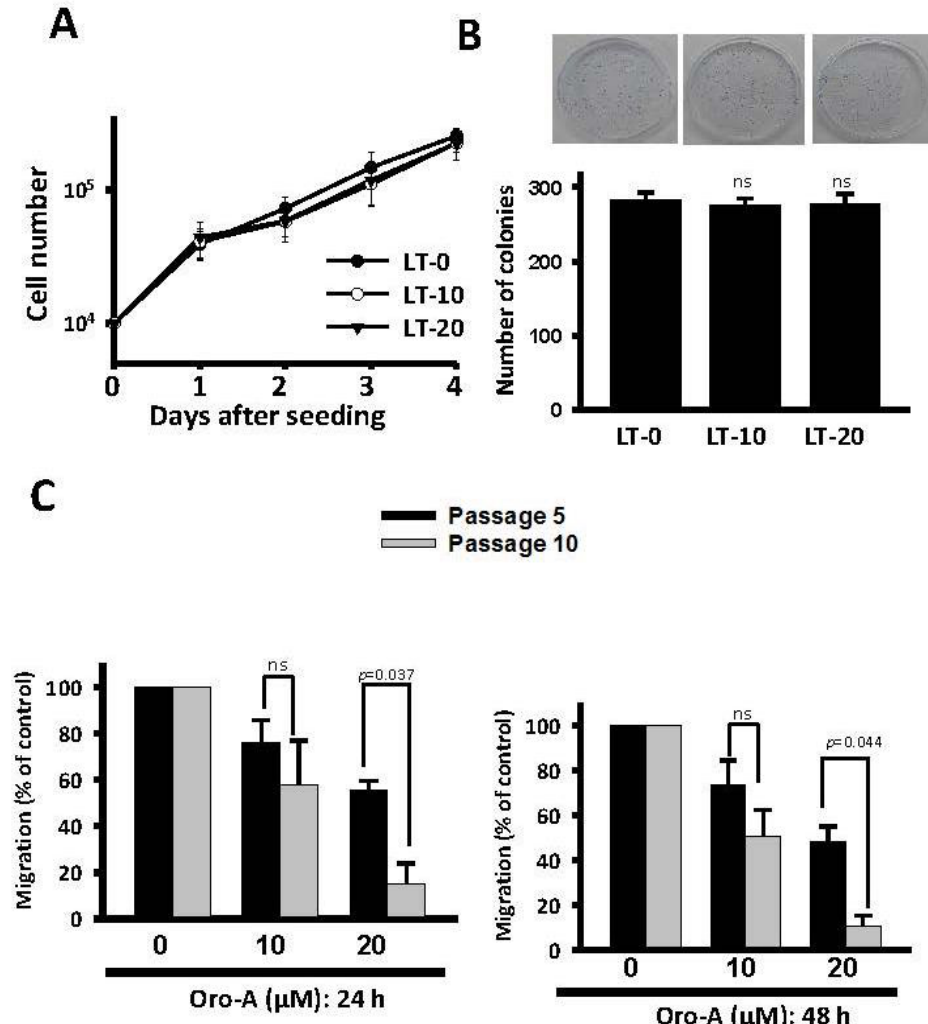
Figure 2 : Long-term effect of Oro-A on the migration activity of OSCC cells. CAL27 cells were treated with vehicle (DMSO) or long-term exposure to Oro- A (10 and 20 μM) for 10 passages . Long-term Oro-A-exposed OSCC cells were designated LT-10 and -20 cells. The growth rates of LT-10 and -20 cells were analyzed with ( A ) trpan blue dye exclusion and ( B ) colony formation assays. ( C ) The migration activity of long-term Oro-A-exposed cells (5 and 10 passages) was determined with wound healing assays. All experiments were performed at least three times. P values were determined using Stude nt’s t test. Ns: not significant.